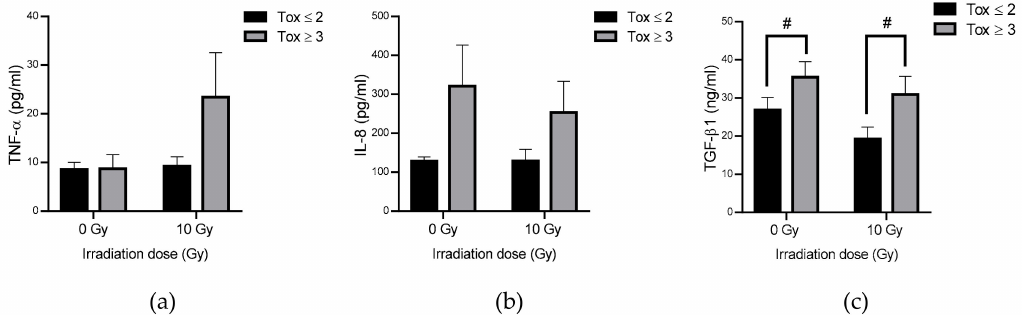
Figure 5. TNF- α (Tumor Necrosis Factor α ) ( a ), IL-8 (Interleukin 8) ( b ) and TGF- β 1 (Transforming Growth Factor β 1) ( c ) concentration in plasma in both groups of patients. Groups Tox ≤ 2 and Tox ≥ 3 correspond to patients presenting grade 2 or less and grade 3 or more of late skin reactions after RT according to RTOG / EORTC, respectively. # for p < 0.05 for Tox ≥ 3 compared to Tox ≤ 2